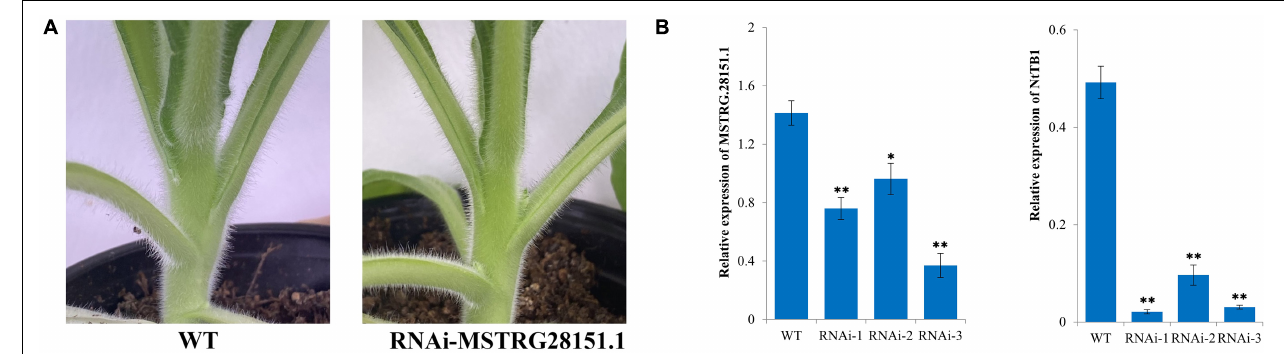
FIGURE 9 | Functional validation of MSTRG.28151.1. (A) Phenotype of an axillary bud from MSTRG.28151–RNAi plants. (B) Expression levels of NtTB 1 and MSTRG.28151.1 in the MSTRG.28151–RNAi plants. The vertical bars indicate standard error ( n = 3). ∗ P < 0.05, significant correlation; ∗∗ P < 0.01, extremely significant